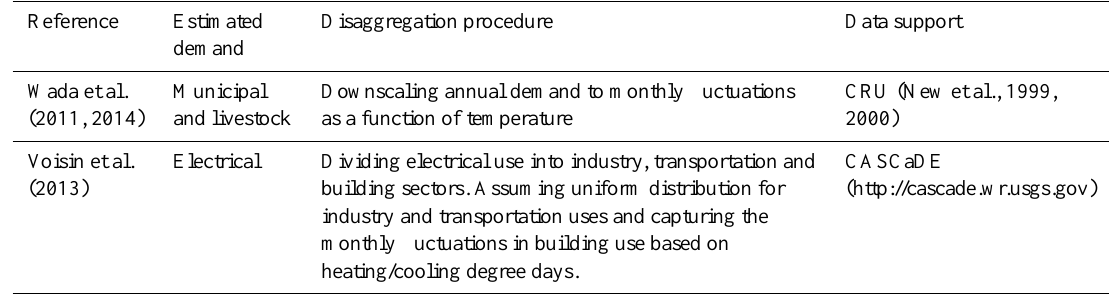
Table 5. Representative examples for disaggregating annual non-irrigative demand into monthly estimates.